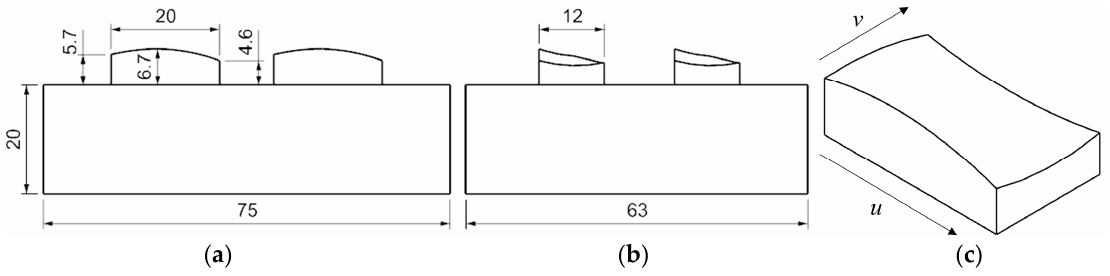
Figure 5. Illustration of the measurement points on Surface one. In this study, we used the functions in NX Open API to perform both the curve fitting and the surface fitting. After obtaining the compensation points, we used the points on the same v coordinate to perform curve fitting along the u -direction, and the points on the same u coordinate to perform curve fitting along the v -direction. The two groups of curves were then used for surface fitting. The order of the fitted curve was determined using the criteria that the average of the distances from the compensation points to the fitted curve must be less than a threshold, which was set at 1 μ m in the study. It was found that we could use the third-degree curves to achieve this. NX includes at least five surface fitting methods: Studio Surface, Fit Surface, Through Curves, Through Curve Mesh, and UFun. To evaluate the methods, we designed two experiments: One was to use the five methods with a set of the compensation points for each surface design to fit surfaces, and find the average of the distances, d 1 , from the compensation points to the fitted surface. The other was to arbitrarily pick up 1000 points from the surfaces of the reconstructed CAD models, and